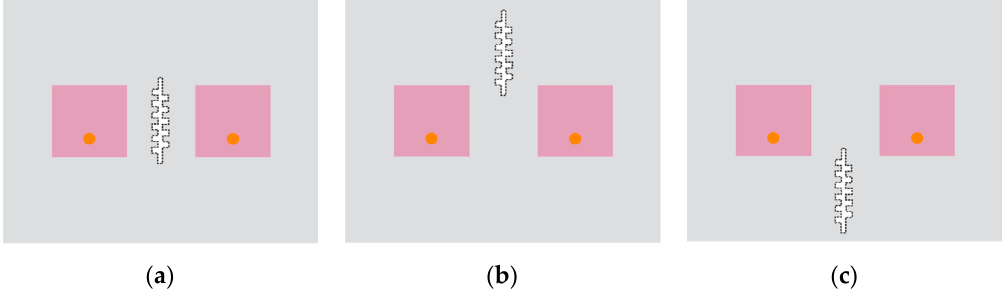
Figure 3. Different locations of the DGS unit on the ground plane side of MIMO antenna. ( a ) In the middle position; ( b ) At the top position; ( c ) At the bottom position, of the antenna back side, to check the isolation of two ports between antenna elements.